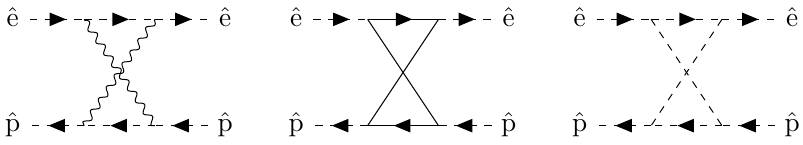
Figure 2 . Examples of crossed one-loop diagrams which can also contribute to the bound state energy at α 4